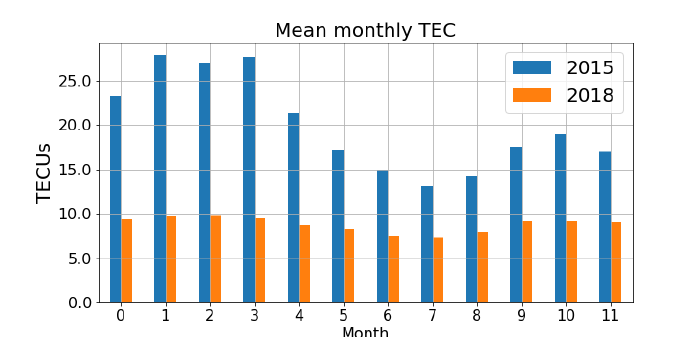
Figure 1. Mean monthly TEC for the years 2015 (in blue) and 2018 (in orange). One parameter to be adjusted is the number Num NN used to calculate the